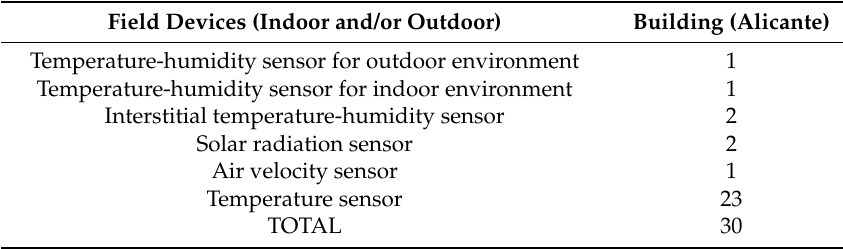
Table 2. The general map of the sensor system to monitor the type C flat.